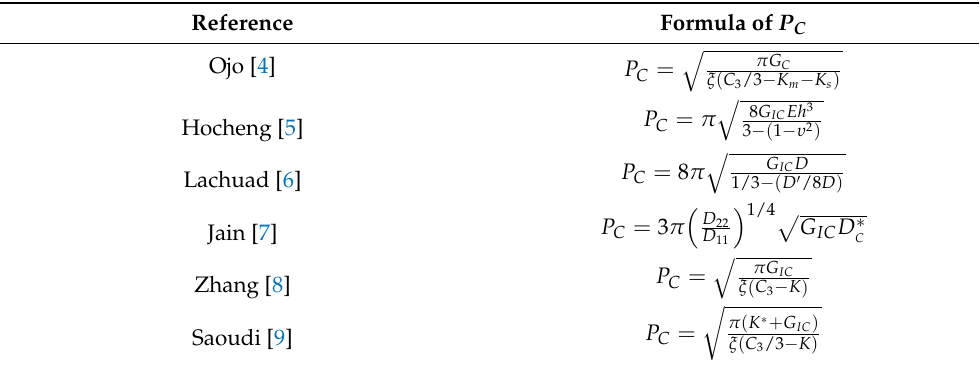
Table 1. Summary of P C Prediction